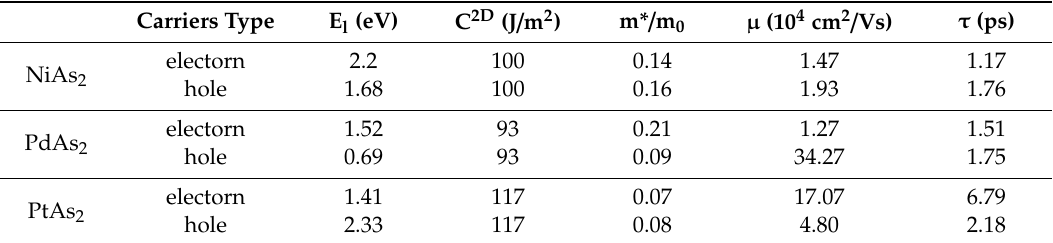
Table 2. Deformation potential (DP) constant E l , 2D elastic constants C 2D , effective mass m*, carrier mobility μ , and scattering time τ for electron (e) and hole (h) along conveyor directions in the 2D monolayer MAs 2 sheet at 300 K.